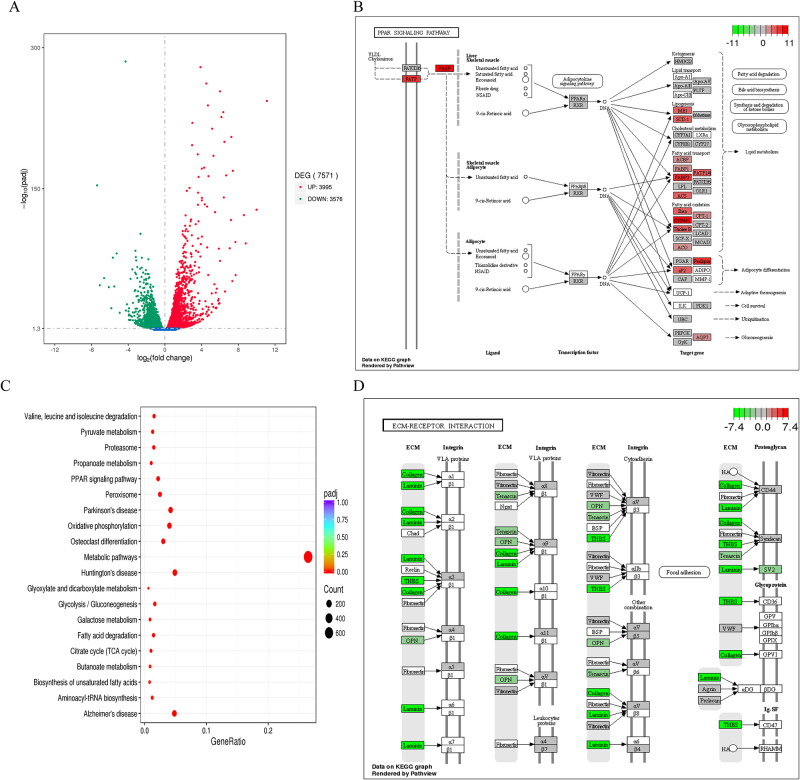
Effect of GFT505 on the genes expression of PPAR signaling pathway and ECM-receptor interaction pathway.(A) The differentially expressed genes in GFT505 (30mpk) group, compared with vehicle group. Red dots represent up-regulated DEGs, the green dots represent down-regulated DEGs, and blue dots represent non-DEGs. A total of 7571 unigenes were identified as DEGs (p < 0.005 and log2 [fold change] > 1) between treatment and vehicle group. (B) KEGG enrichment analysis of DEGs. Top 20 significantly enriched KEGG pathway. (C) DEGs enriched in “PPAR Signaling pathway”. (D), DEGs enriched in “ECM-Receptor interaction”. Vehicle and GFT505 group: CDAHFD diet. DEGs, Differentially Expressed Genes; KEGG, Kyoto Encyclopedia of Genes and Genomes; ECM, Extracellular matrix.